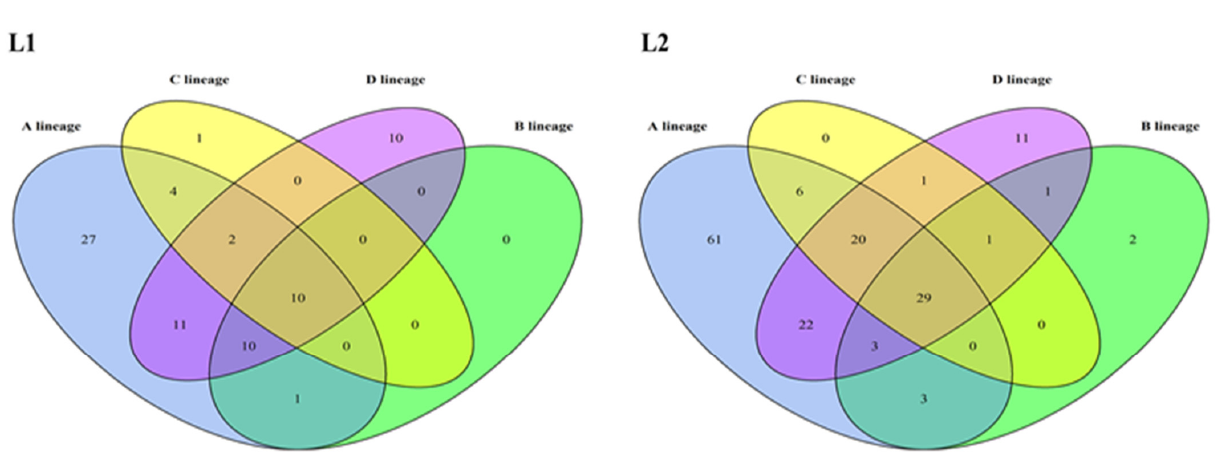
Figure 2. The lineage distribution of potential glycosylation sites in L1 and L2